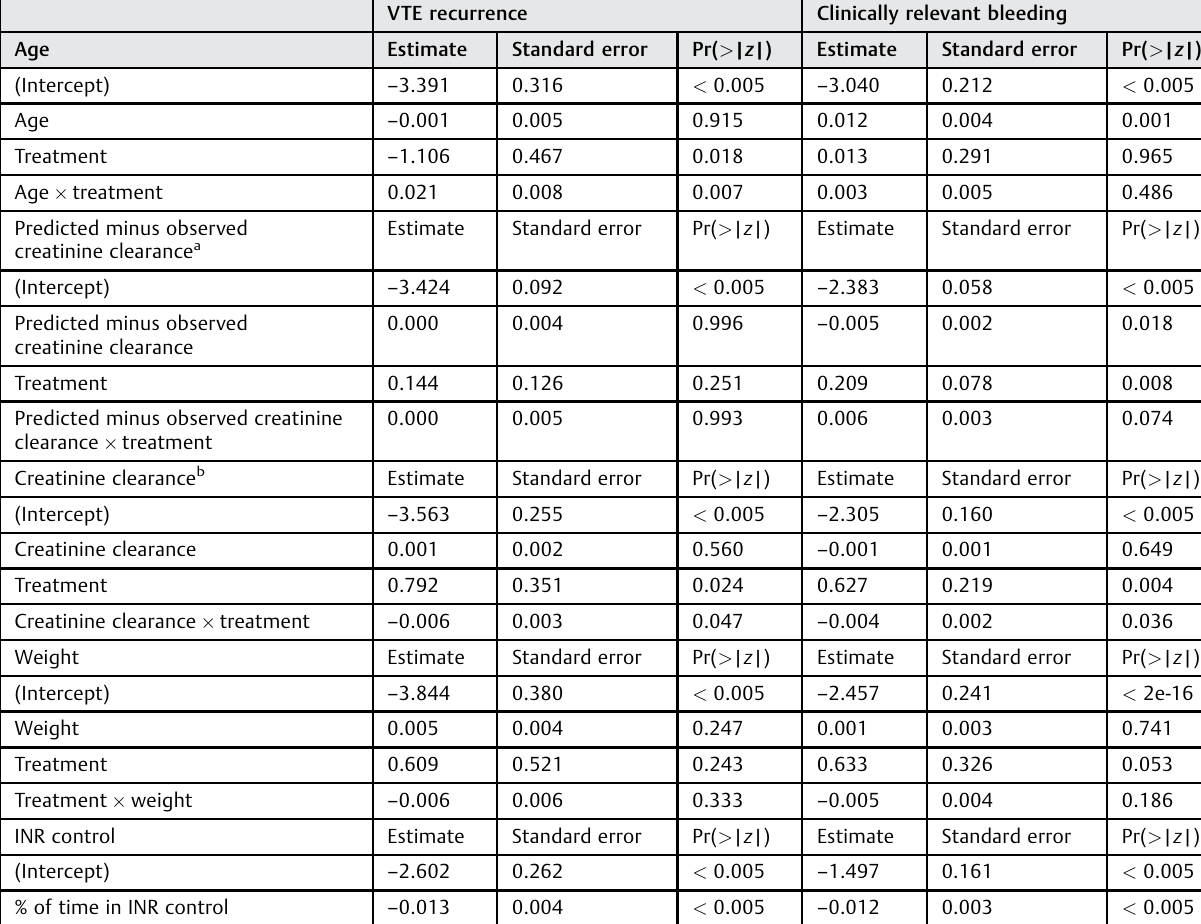
Table 2 Univariate analysis of ef fi cacy and safety event